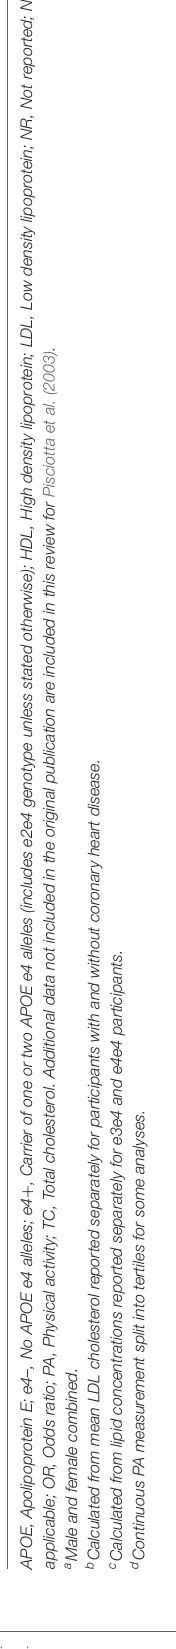
( Supplementary Figure 1 ) indicated possible publication